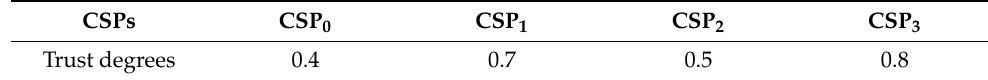
Table 3. The CSPs and their trust degrees.